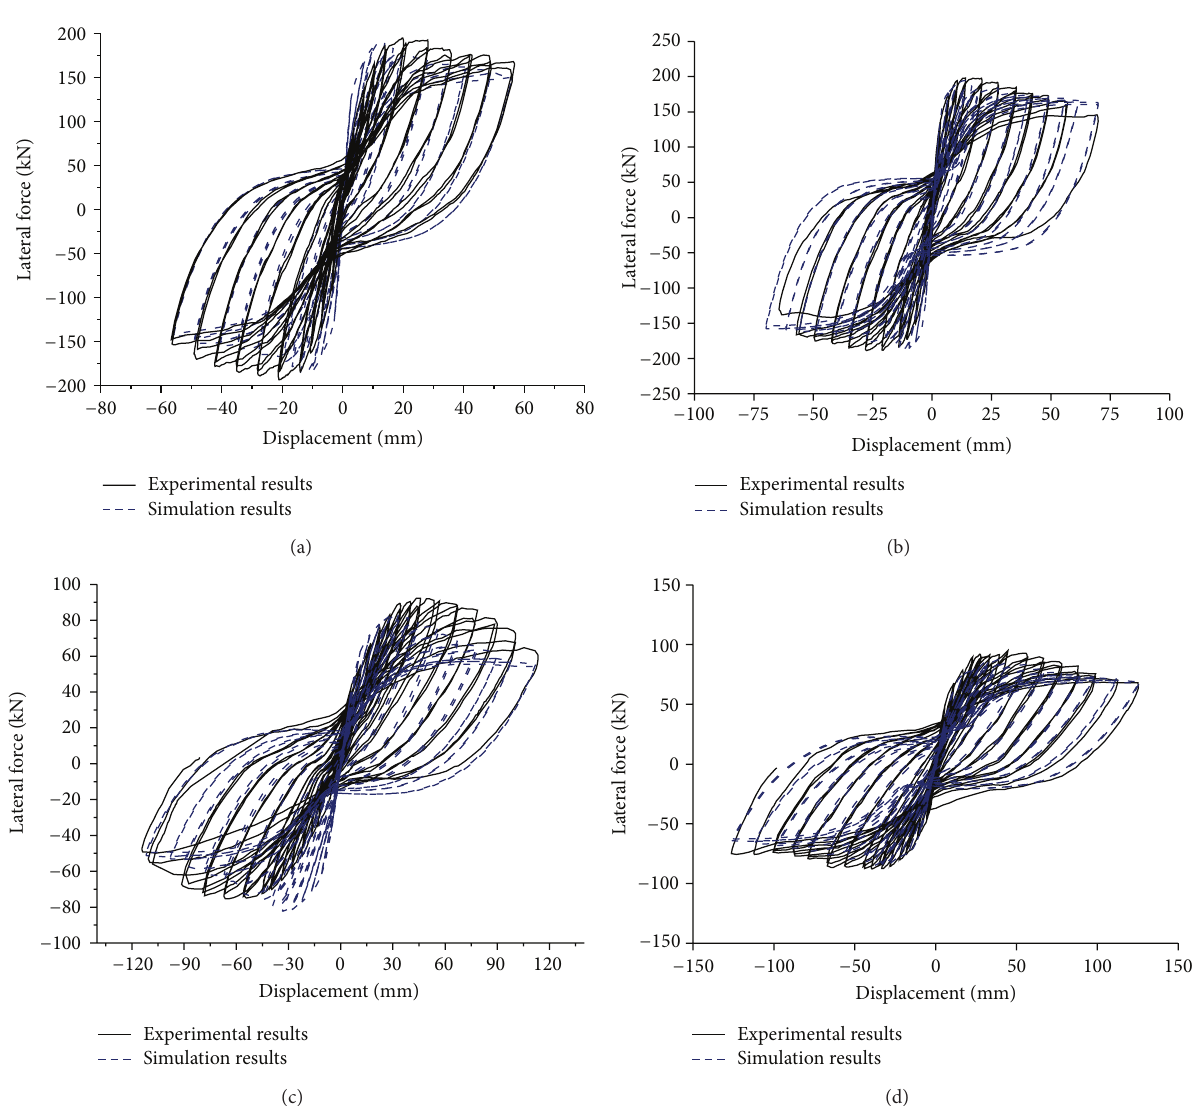
Figure 9: Hysteretic curves comparison of test results with proposed model (a) SU-1, (b) SHG-3, (c) LU-1, and (d)